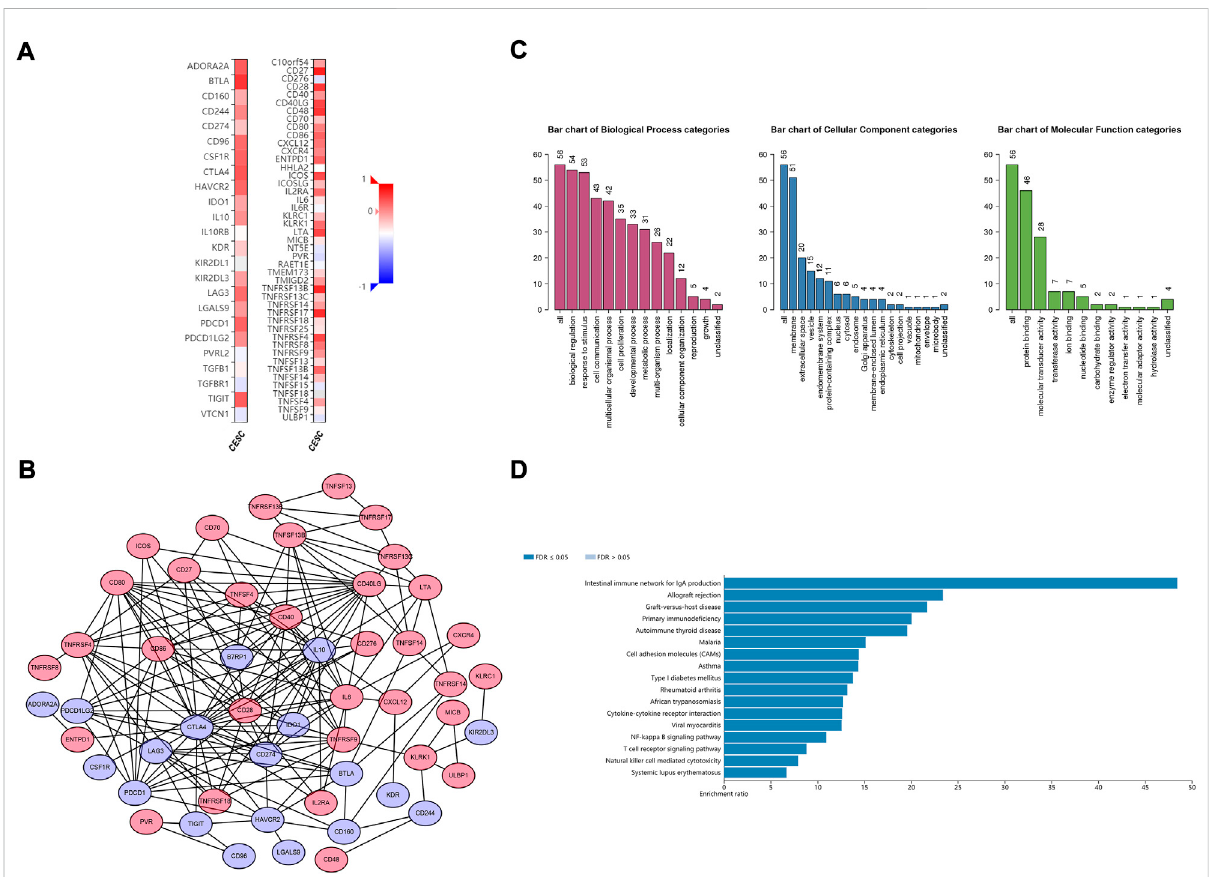
FIGURE 6 Identi fi cationandanalysis oftheCD79B-associatedimmunomodulators. (A) HeatmapsofCD79B-associatedimmunoinhibitors(leftpanel)and immunostimulators (right panel) in the CESC cohorts. (B) The PPI network concerning the 52 CD79B-associated immunomodulators, including immunoinhibitors (blue node) and immunostimulators (red node), as visualized by Cytoscape (C and D) GO (C) and KEGG pathway (D) enrichment analysis results for 52 immunomodulators from the PPI network based on the CESC cohorts that are highly likely to have an interactive